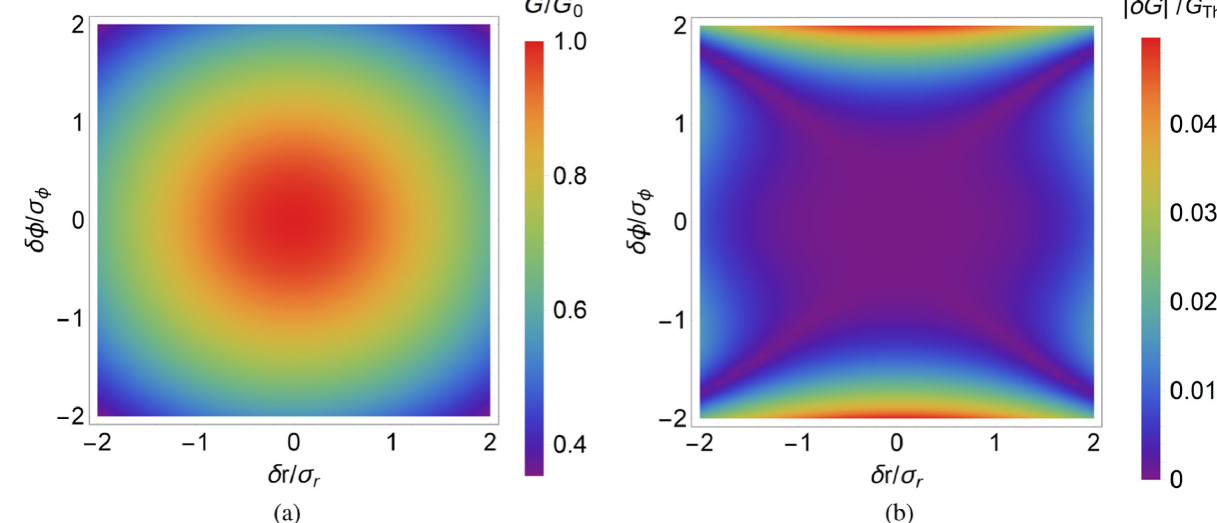
FIG. 3. (a) Density plot of (a) normalized 3D gain calculated for mismatch between radiation and electron beams at the waist location in one dimension, with error values normalized to rms widths of radiation beam, and (b) difference in normalized gain calculated from theory [Eq. (23)] and the Gaussian approximation [Eq. (25)] for a range of error values used in Fig. 3(a).